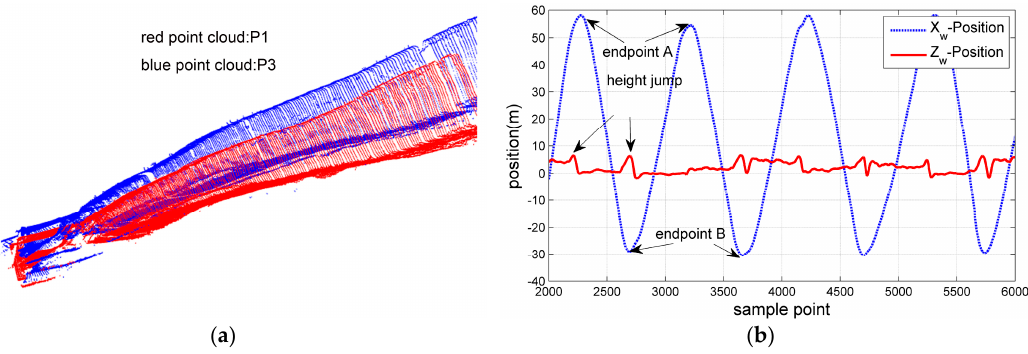
Figure 10. Deflection phenomenon caused by the helicopter position inaccuracy in flying ‐ scan mode, ( a ) lateral view of one wall segment with two point clouds; ( b ) position measurement during the flying ‐ scan.